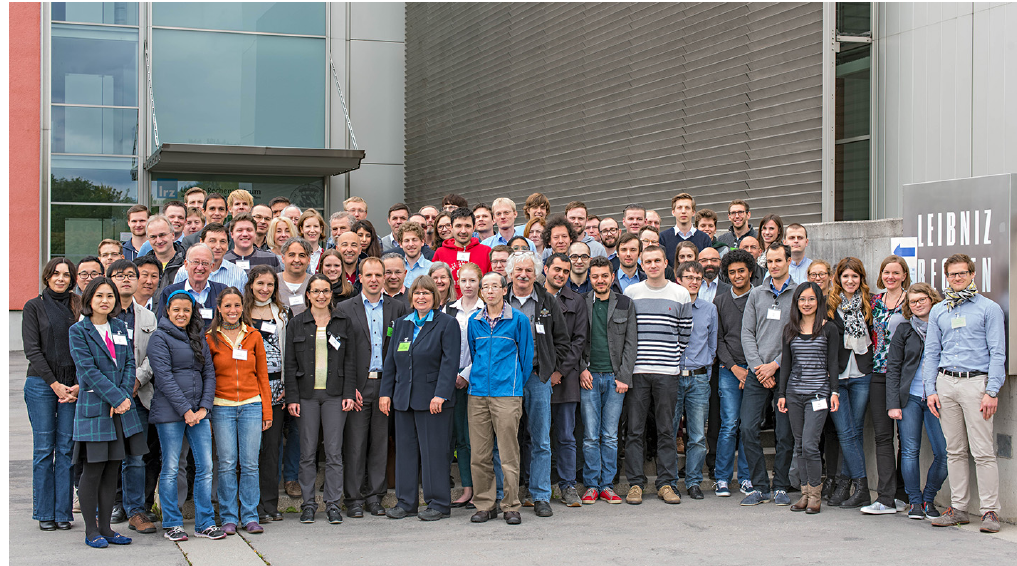
Figure 4: Group photo taken at the workshop “Dependence Modeling in Finance, Insurance and Environmental Science”